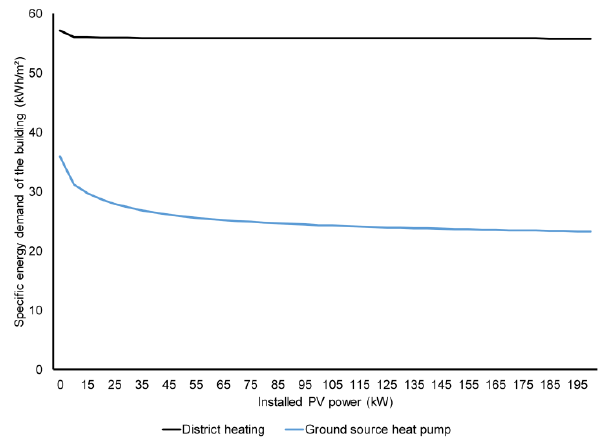
Figure 6. Specific energy demand for the building equipped with GSHP and DH as a function of installed PV power.